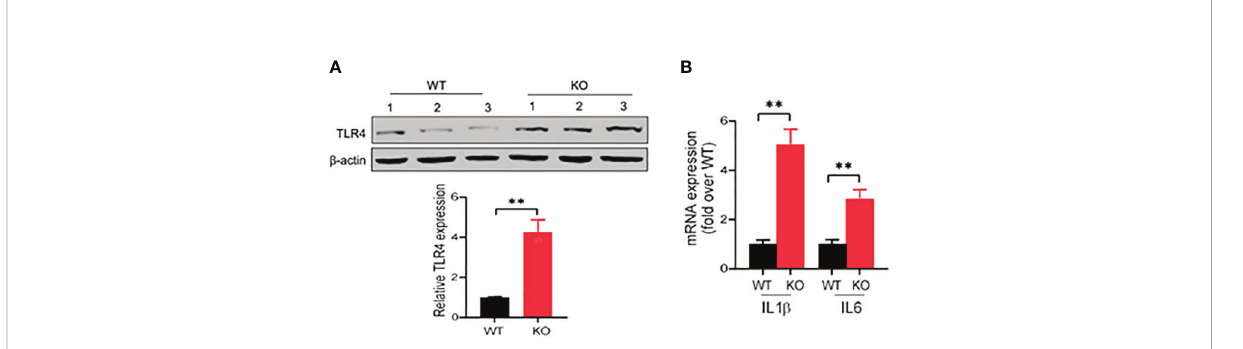
FIGURE 6 Activation of TLR4 signaling in colon of AKR1B8 KO mice under acute colitis. Colonic mucosa was collected and processed for Western blot and qRT-PCR as described in th Materials and Methods. (A) Western blot, demonstrating TLR4 protein expression level in the mucosa under acute colitis on day 6. Relative expression level of TLR4 was calculated using image J software ( Lower panel ). (B) Expression levels of IL1 b and IL6 in colonic mucosa under acute colitis on day 6. KO, knockout; WT, wild type. **p <